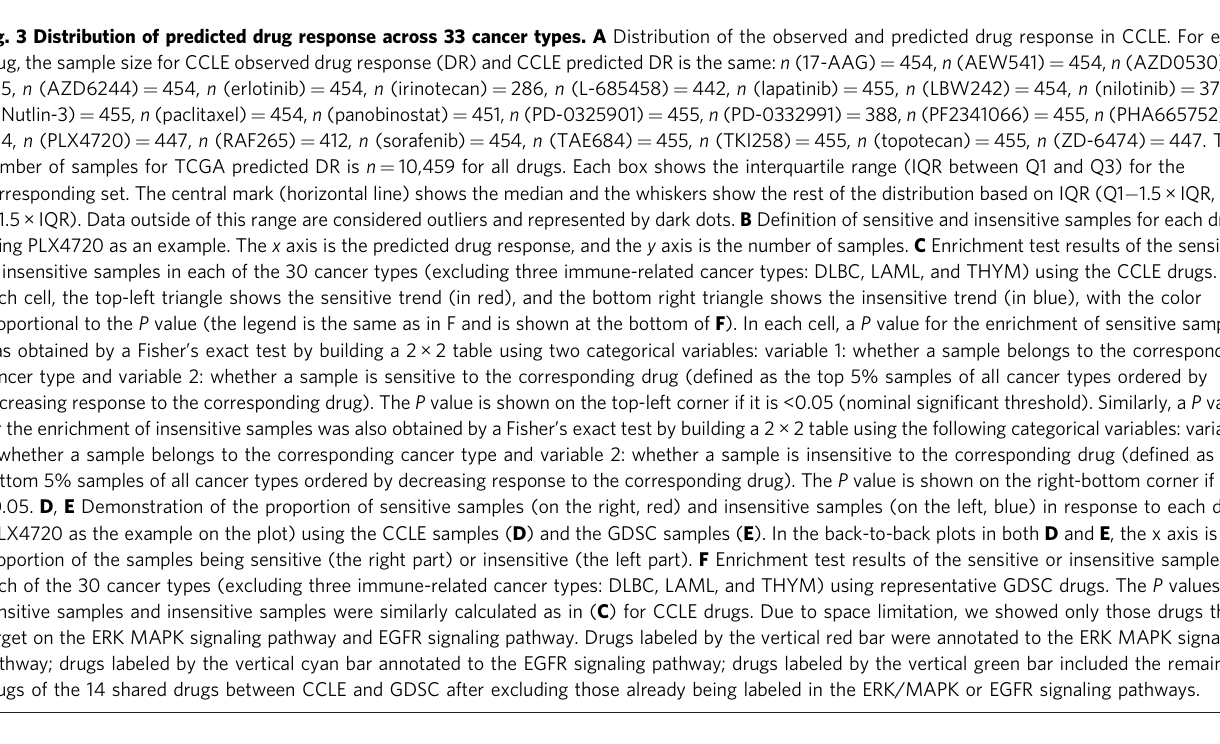
Fig. 3 Distribution of predicted drug response across 33 cancer types. A Distribution of the observed and predicted drug response in CCLE. For each drug, the sample size for CCLE observed drug response (DR) and CCLE predicted DR is the same: n (17-AAG) = 454, n (AEW541) = 454, n (AZD0530) = 455, n (AZD6244) = 454, n (erlotinib) = 454, n (irinotecan) = 286, n (L-685458) = 442, n (lapatinib) = 455, n (LBW242) = 454, n (nilotinib) = 375, n (Nutlin-3) = 455, n (paclitaxel) = 454, n (panobinostat) = 451, n (PD-0325901) = 455, n (PD-0332991) = 388, n (PF2341066) = 455, n (PHA665752) = 454, n (PLX4720) = 447, n (RAF265) = 412, n (sorafenib) = 454, n (TAE684) = 455, n (TKI258) = 455, n (topotecan) = 455, n (ZD-6474) = 447.